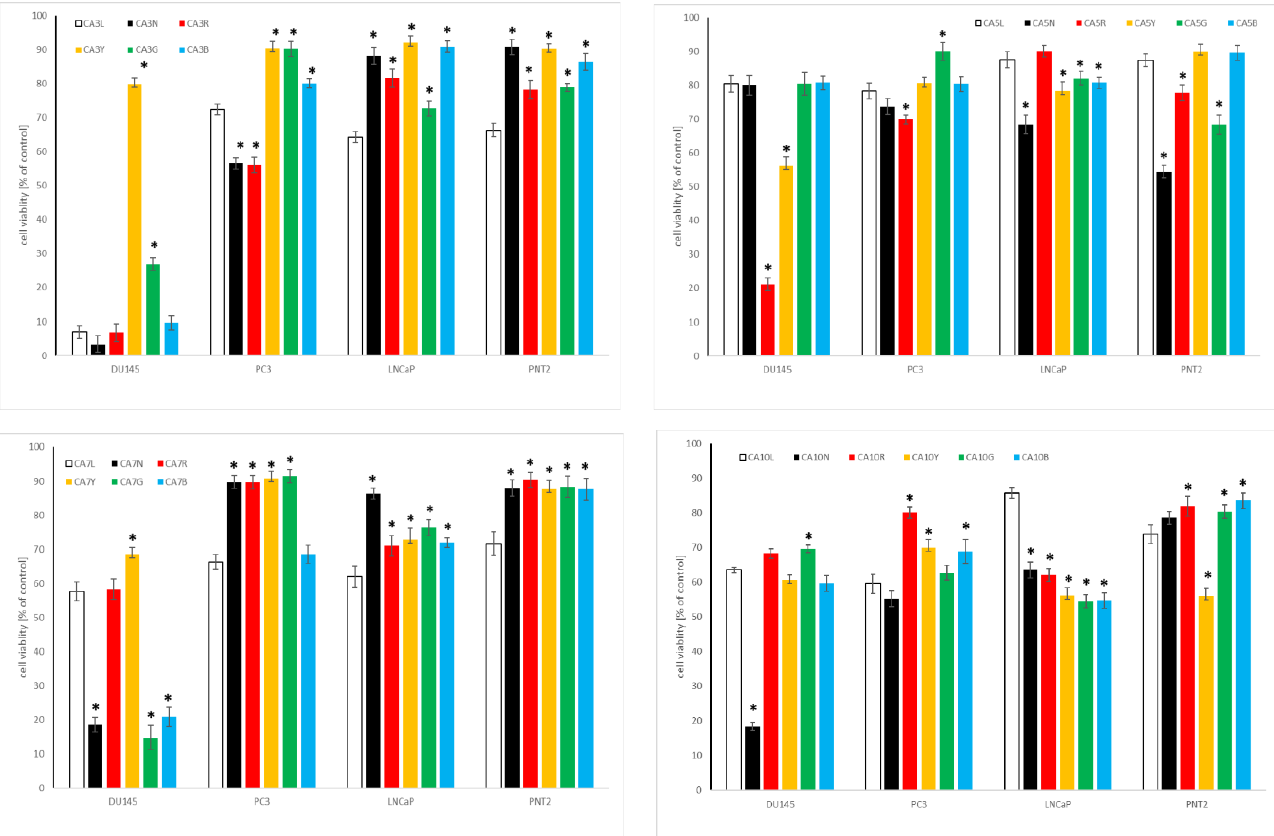
Figure 5. Cytotoxic effect of the extracts of chickpea sprouts (CA) harvested for 3, 5, 7, and 10 days in different LED light conditions: natural (L), darkness (N), red (R), yellow (Y), green (G), blue (B) on prostate normal (PNT2) and cancer (DU145, PC3, LNCaP) cells. Cells were treated with 500 µg/mL of sprout extracts (n = 3) for 24 h. Values are presented as the mean ± SD (standard deviation). Significant differences ( p < 0.05) for each cell line refer to normal sprouts harvesting procedure and are marked as *.